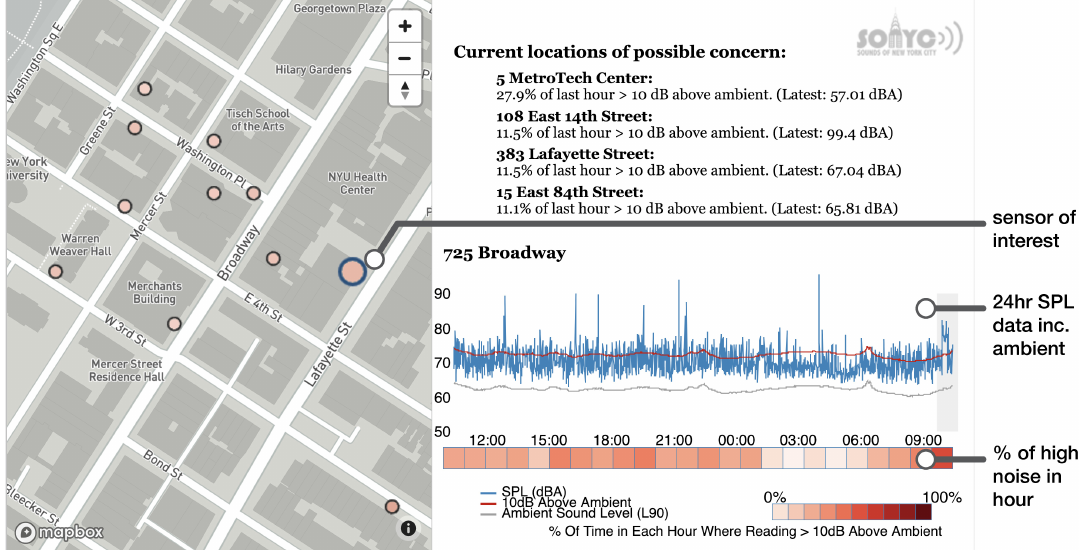
Figure 8. Annotated prototype DEP dashboard showing real-time sensor data across a heavily deployed area of